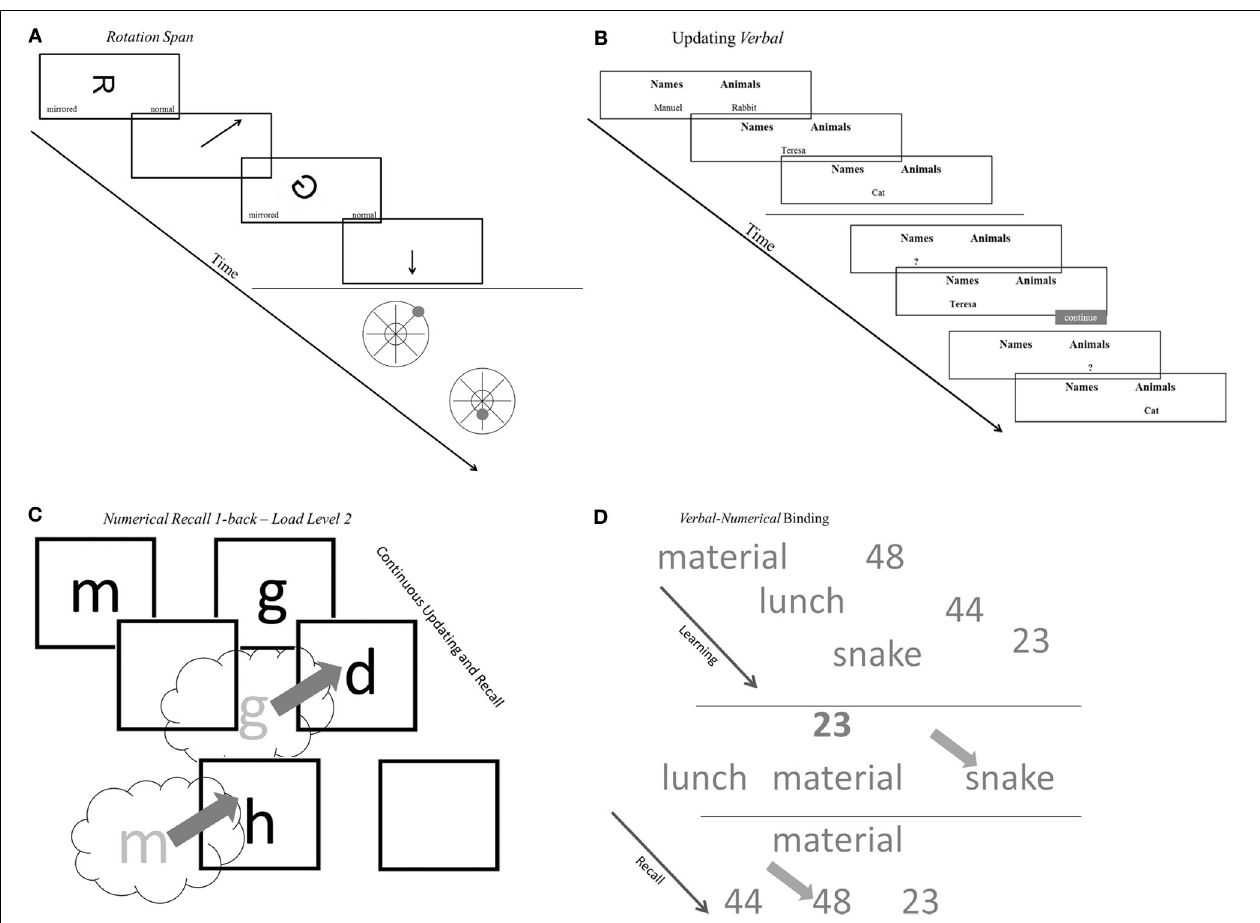
FIGURE 2 | Schematic representations of tasks. (A) Schematic representations of complex span tasks (rotation span). (B) Schematic representations of updating tasks (updating verbal). (C) Schematic